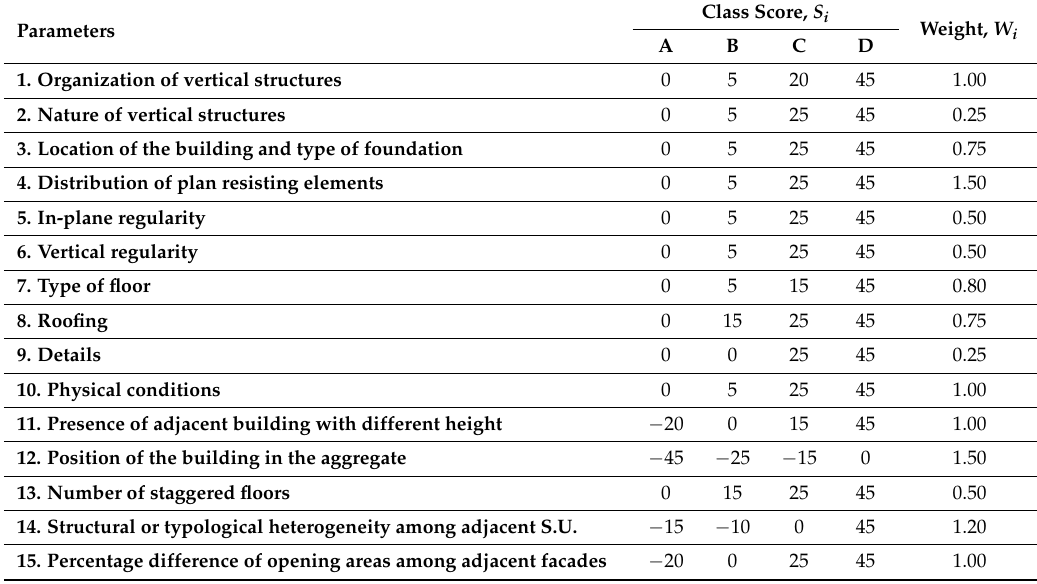
Table 1. The vulnerability form for historical building